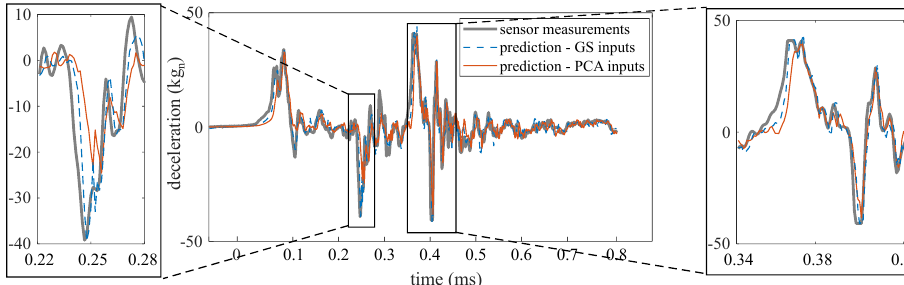
Figure 8. One-step ahead prediction, “PCA inputs” versus “GS inputs”.